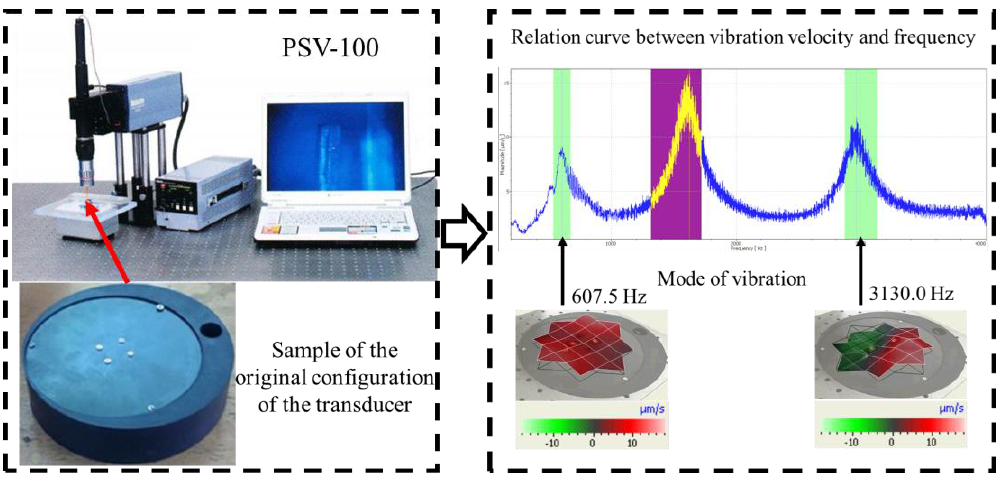
Figure 7. Grid and impose constraints.